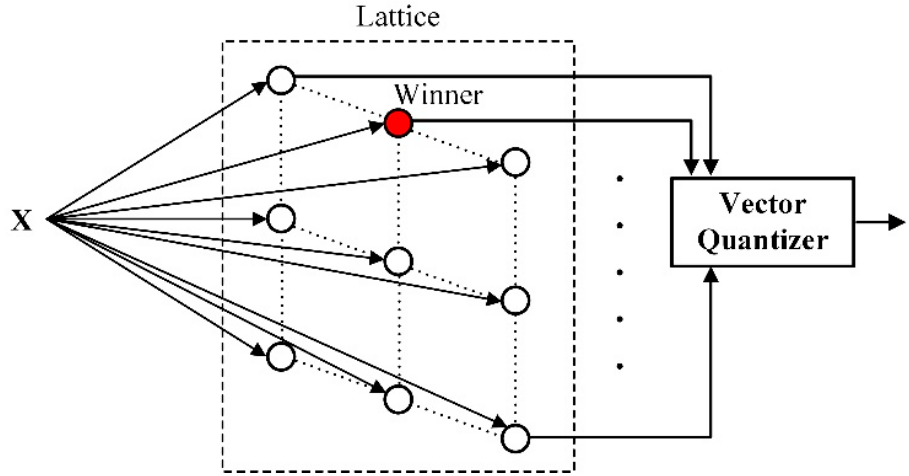
Figure 3. SOM Figure 3. SOM algorithm.